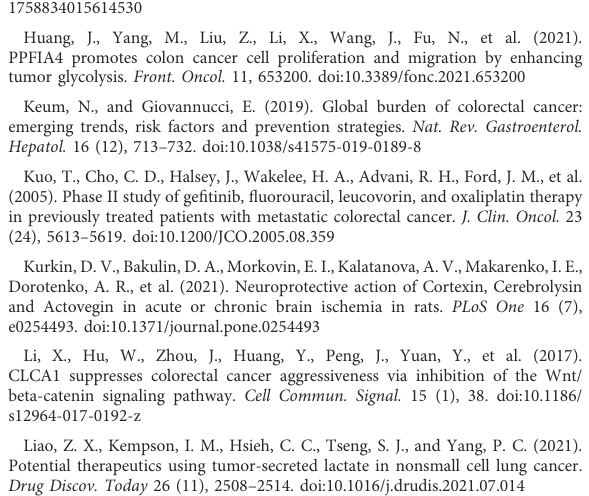
SUPPLEMENTARY FIGURE S4 (A) Relationships between the glycolysis- and lactate-related gene prognostic signature and CYT activity score. (B) Relationships between the glycolysis- and lactate-related gene prognostic signature and the TMB. SUPPLEMENTARY FIGURE S5 Representativeimmunohistochemistryimagesofglycolysis-andlactate- related genes from the Human Protein Atlas